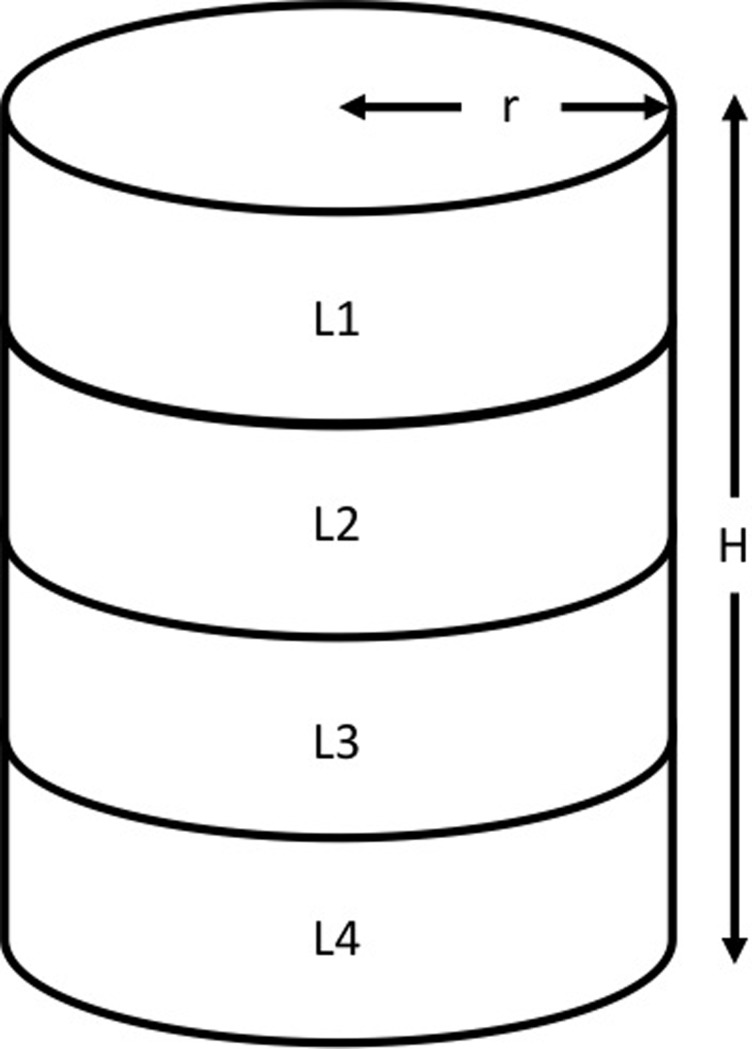
Volumetric calculations of BMD using DEXA data.Where r is radius, H is the height of the lumbar column, L1-4 is each of the respective lumbar vertebrae, adapted from Kröger et al.[34].